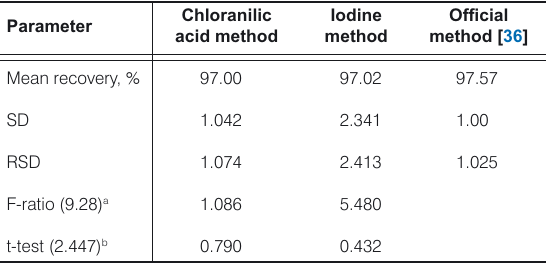
between the proposed and the official method.